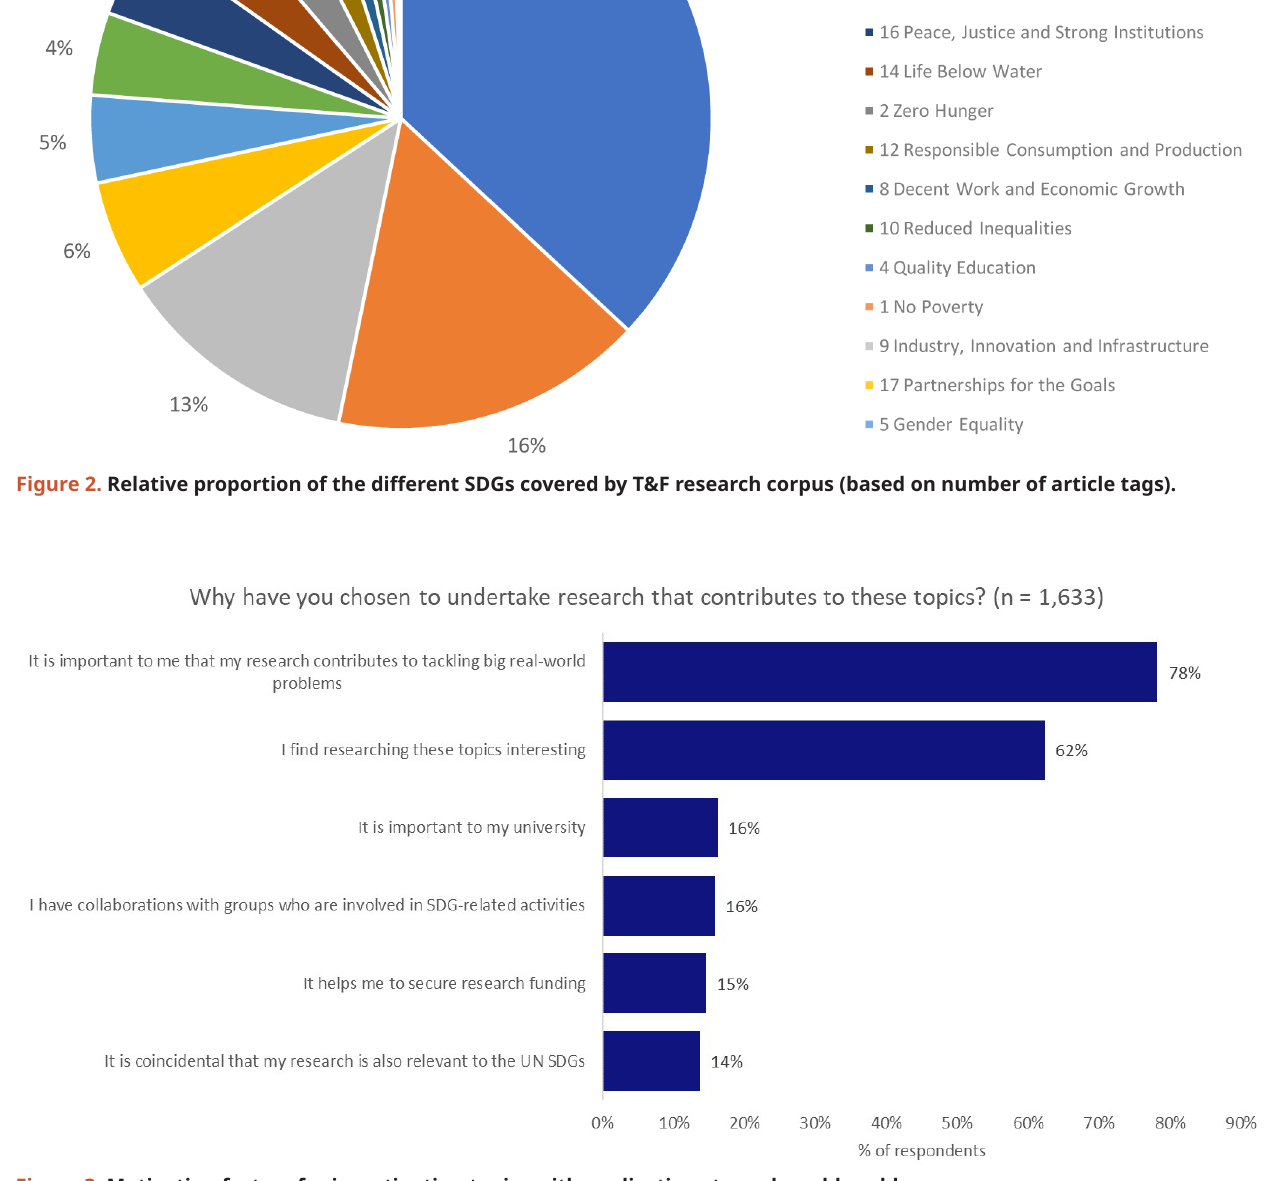
Figure 3. Motivating factors for investigating topics with applications to real-world